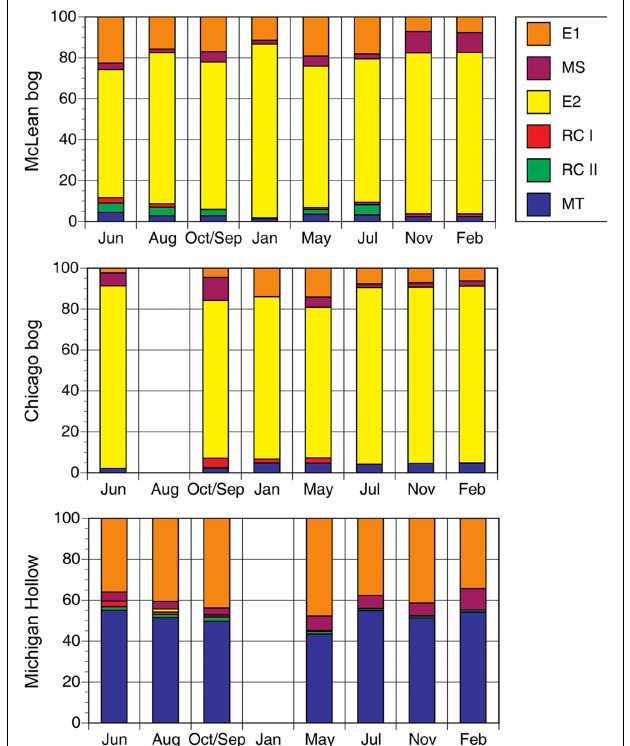
FIGURE 1 | Proportion of major methanogen groups determined by T-RFLP of SSU rRNA gene sequences for soil samples from three peatlands (no addition treatment). Legend indicates groups: E2 (cid:2) (E2) and E1 (cid:2) (E1) in the order Methanomicrobiales; rice cluster-I (RC-I) in the novel order Methanocellales; uncultivated RC-II; and, Methanosarcinaceae (MS) and Methanosaetaceae (MT) in the Methanosarcinales.